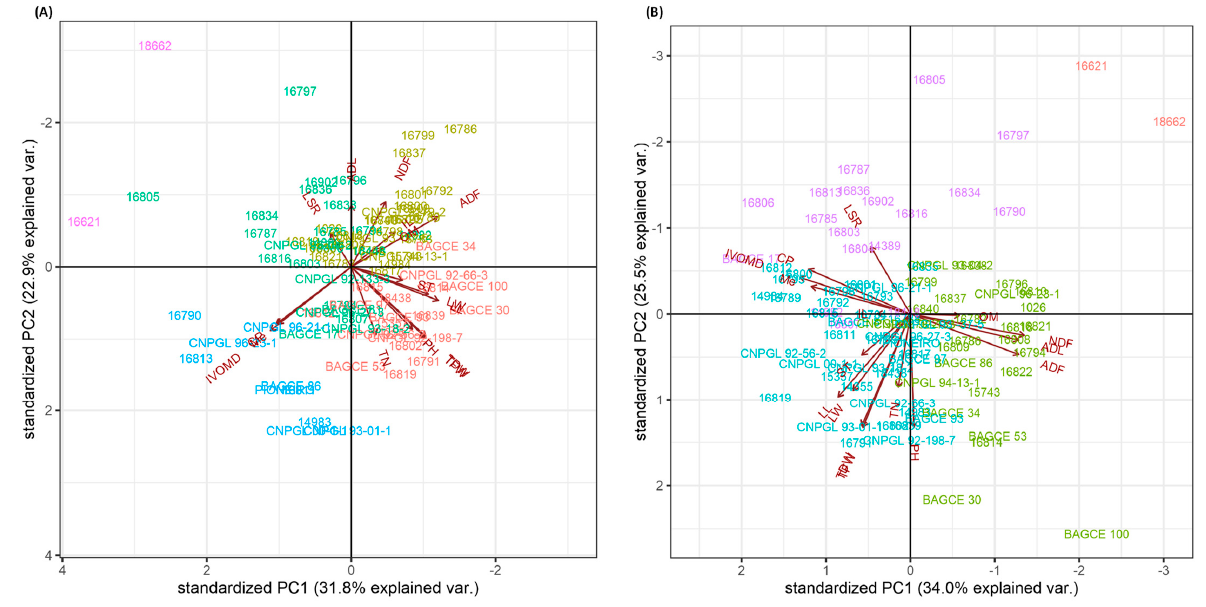
Figure A4. PCA biplots of morphological traits and feed quality traits from: ( A ) leaf tissue samples and ( B ) stem tissue samples of 84 Napier genotypes in the wet season. Genotypes dispersed in different coordinates based on dissimilarity among them. The color of genotypes indicates different cluster groups. The angles between the vectors derived from the mid points of biplots exhibit positive and negative correlations among traits. Plant height (PH), leaf length (LL), leaf width (LW), internode length (IL), stem thickness (ST), tiller number (TN), total fresh weight (TFW), total dry weight (TDW), leaf-to-stem ratio (LSR), neutral detergent fiber (NDF), acid detergent fiber (ADF), acid detergent lignin (ADL), organic matter (OM), crude protein (CP), in vitro organic matter digestibility (IVOMD), metabolizable energy (ME).